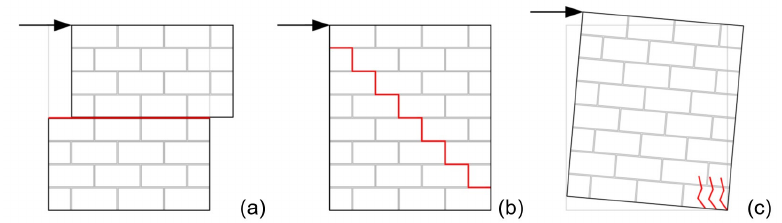
Figure 1. Modes of failure: (a) sliding; (b) diagonal shear; (c) flexural / rocking.